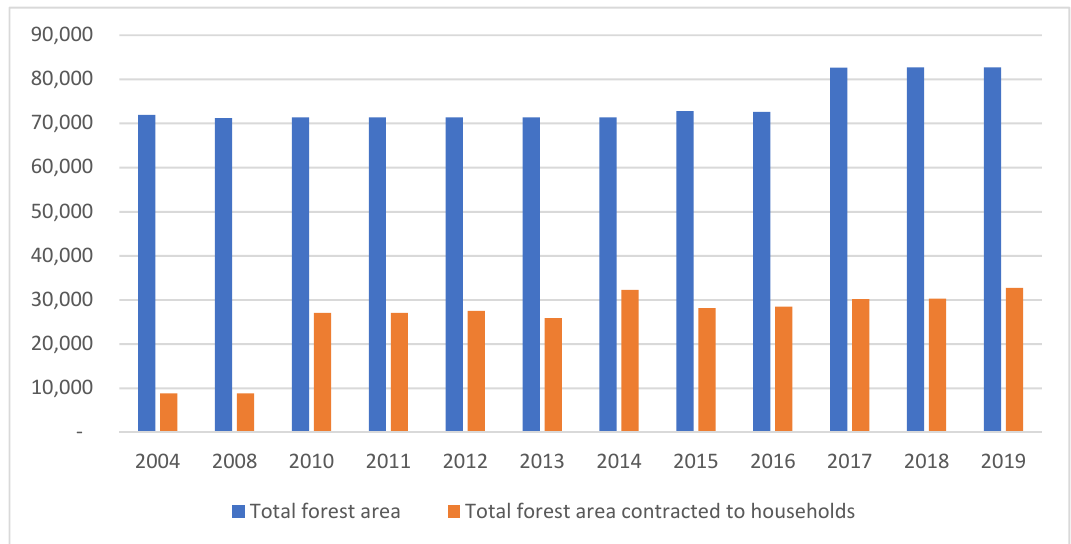
Figure 4. Area allocated to local people before and after PFES (before and after 2010). Source: Cat Tien National Park and compiled by research team.